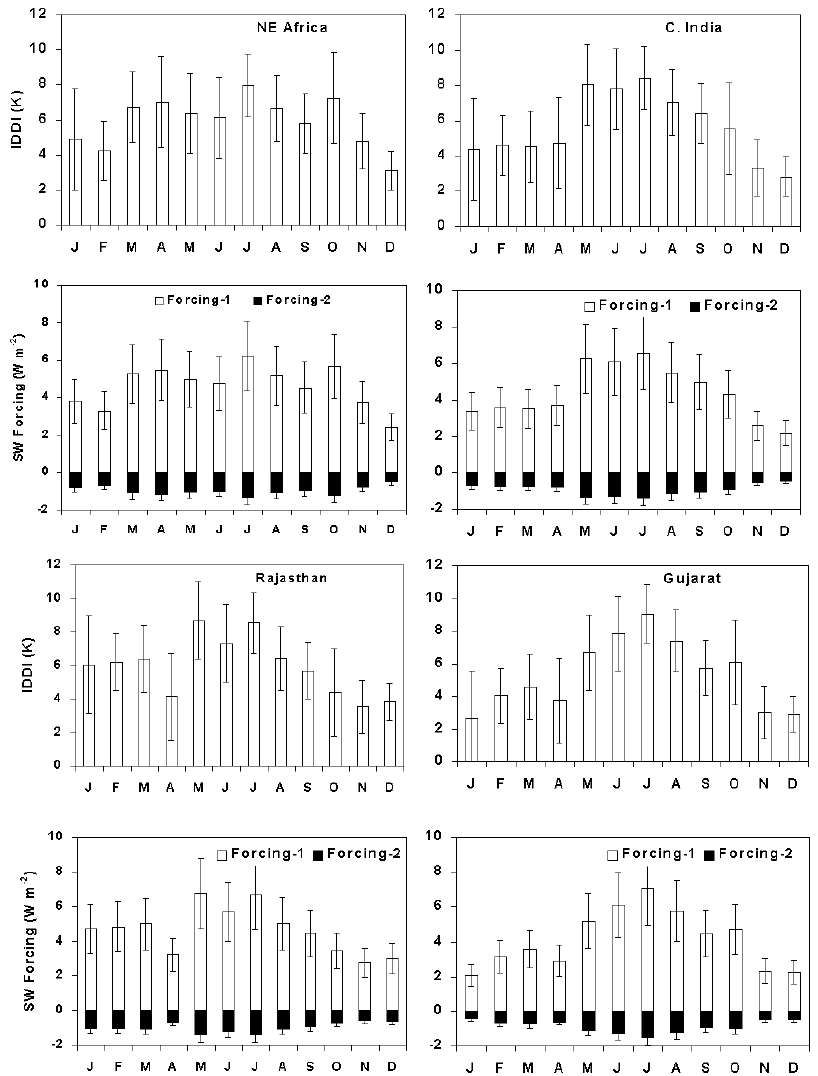
Fig. 13. Monthly mean IDDI and SW dust radiative forcing at four representative regions estimated using two different dust optical properties reported earlier. Table 5. SW dust radiative forcing at top of the atmosphere for